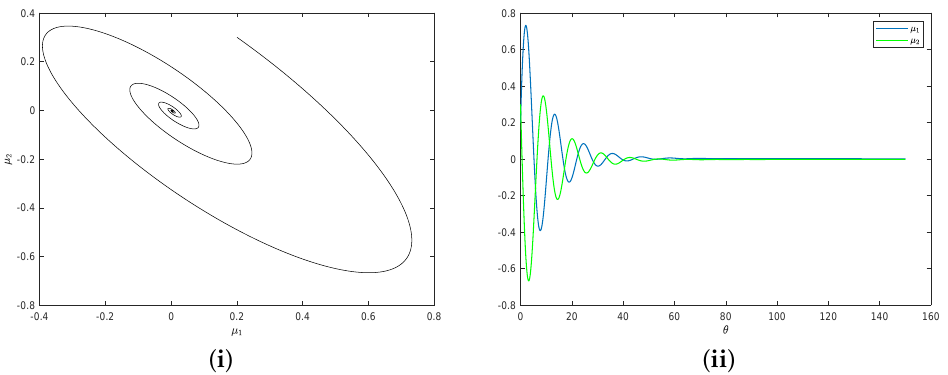
Figure 3. ( i ) Phase diagram of the circuit system for µ 0 = ( 0.2,0.3 ) , a 1 = 0.5, a 2 = 0.3, b = 0.8, c = 2, and f = 0; ( ii ) evolution of the state µ 1 , µ 2 .